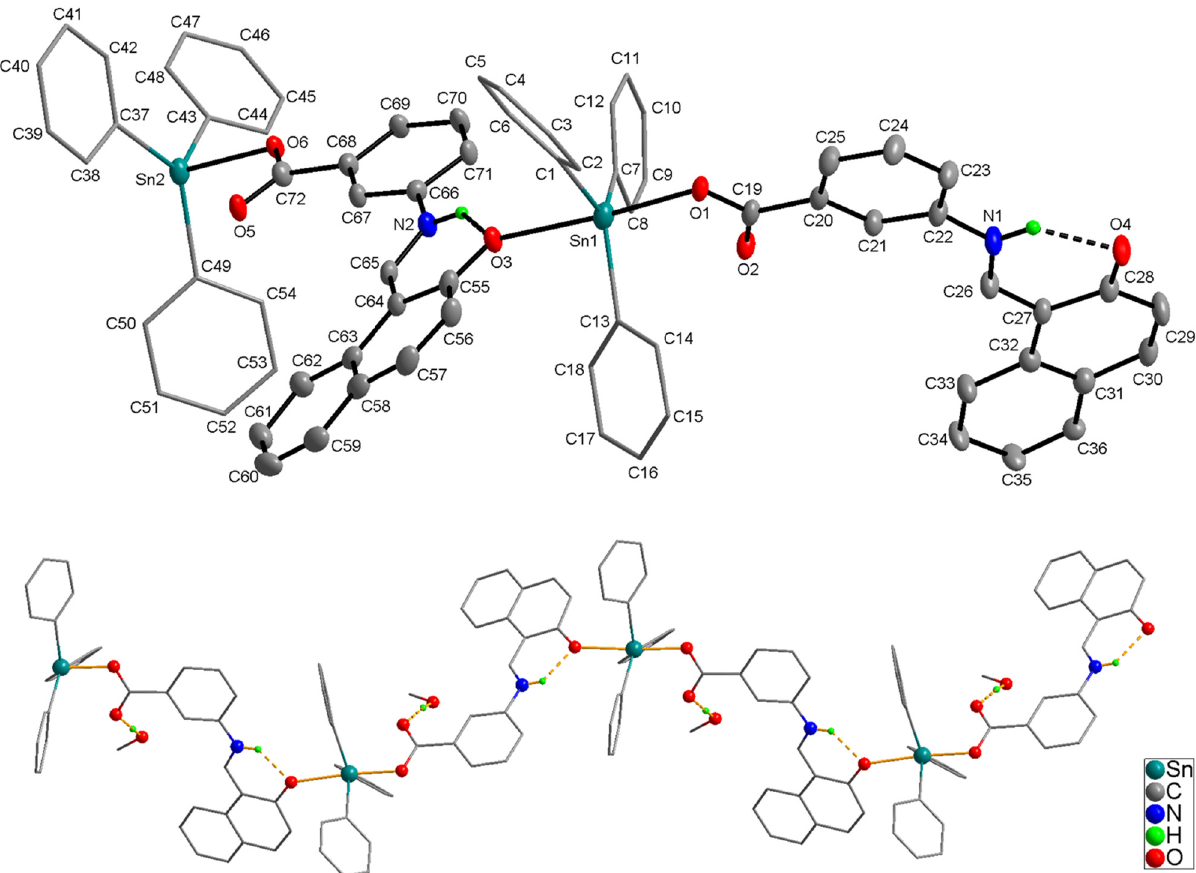
Figure 5: ( Top ) The molecular structure of 5. Ellipsoids are drawn at 30% probability level. For clarity, hydrogen atoms except H1 and H2 atoms and solvent molecules are omitted. ( Bottom ) One - dimensional chain formed by the intermolecular phenolic O → Sn coordination. The solvent molecule CHCl 3 is omitted for